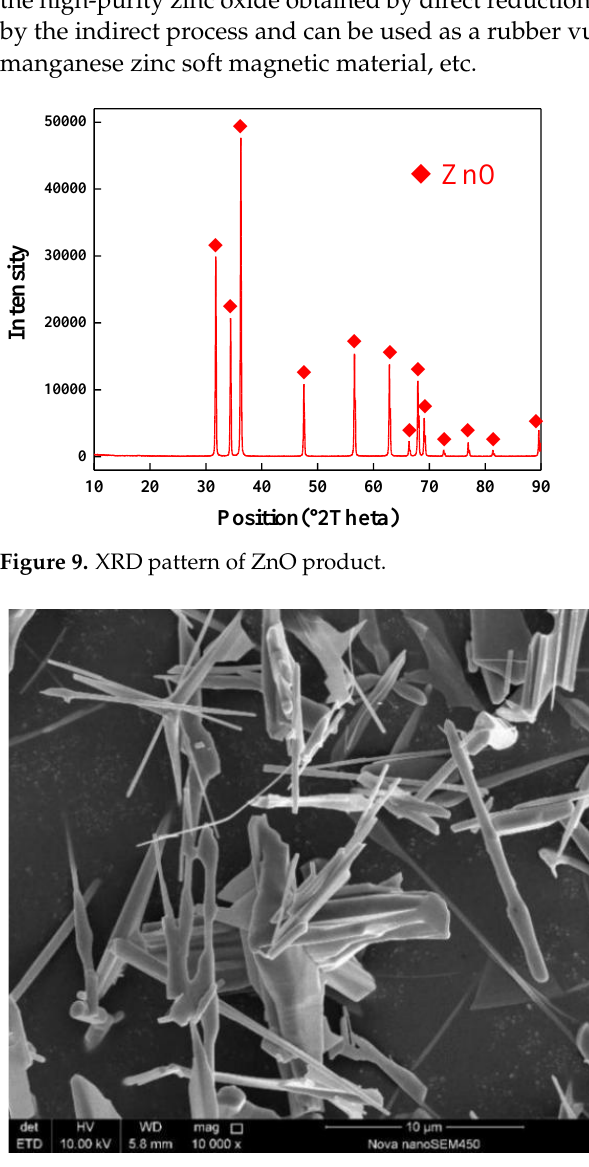
9 of 11 Figure 8. Effect of coal additive amount on reduction rate of zinc ash.